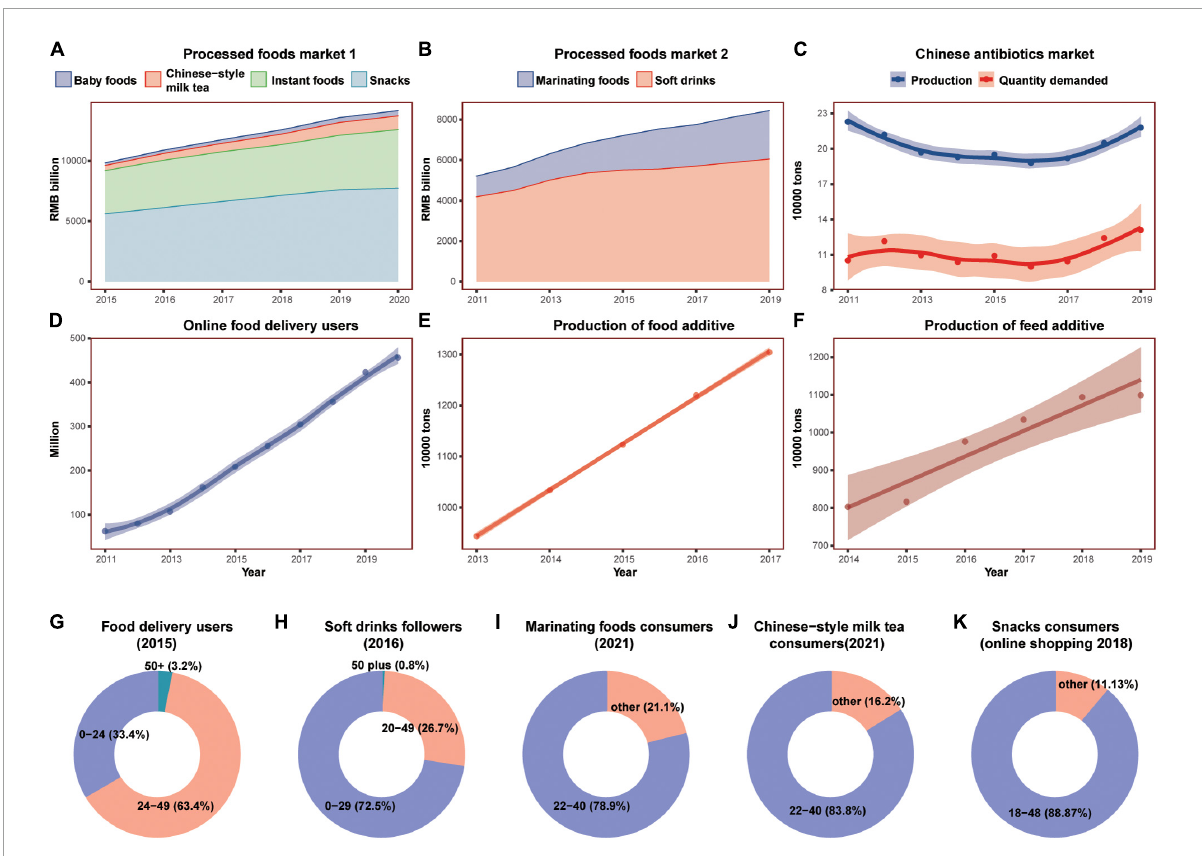
FIGURE8 The surging consumption of processed foods in China in the past decade. (A,B) Showed the market expanding of six highly processed foods; (E,F) showed the rapidly increasing production of additives, and (C) showed the production and demand of antibiotics; (D) showed the rapidly increasing number of online food delivery users; (G–K) showed the age distribution of major processed food consumers. Shaded sections indicate 95% uncertainty